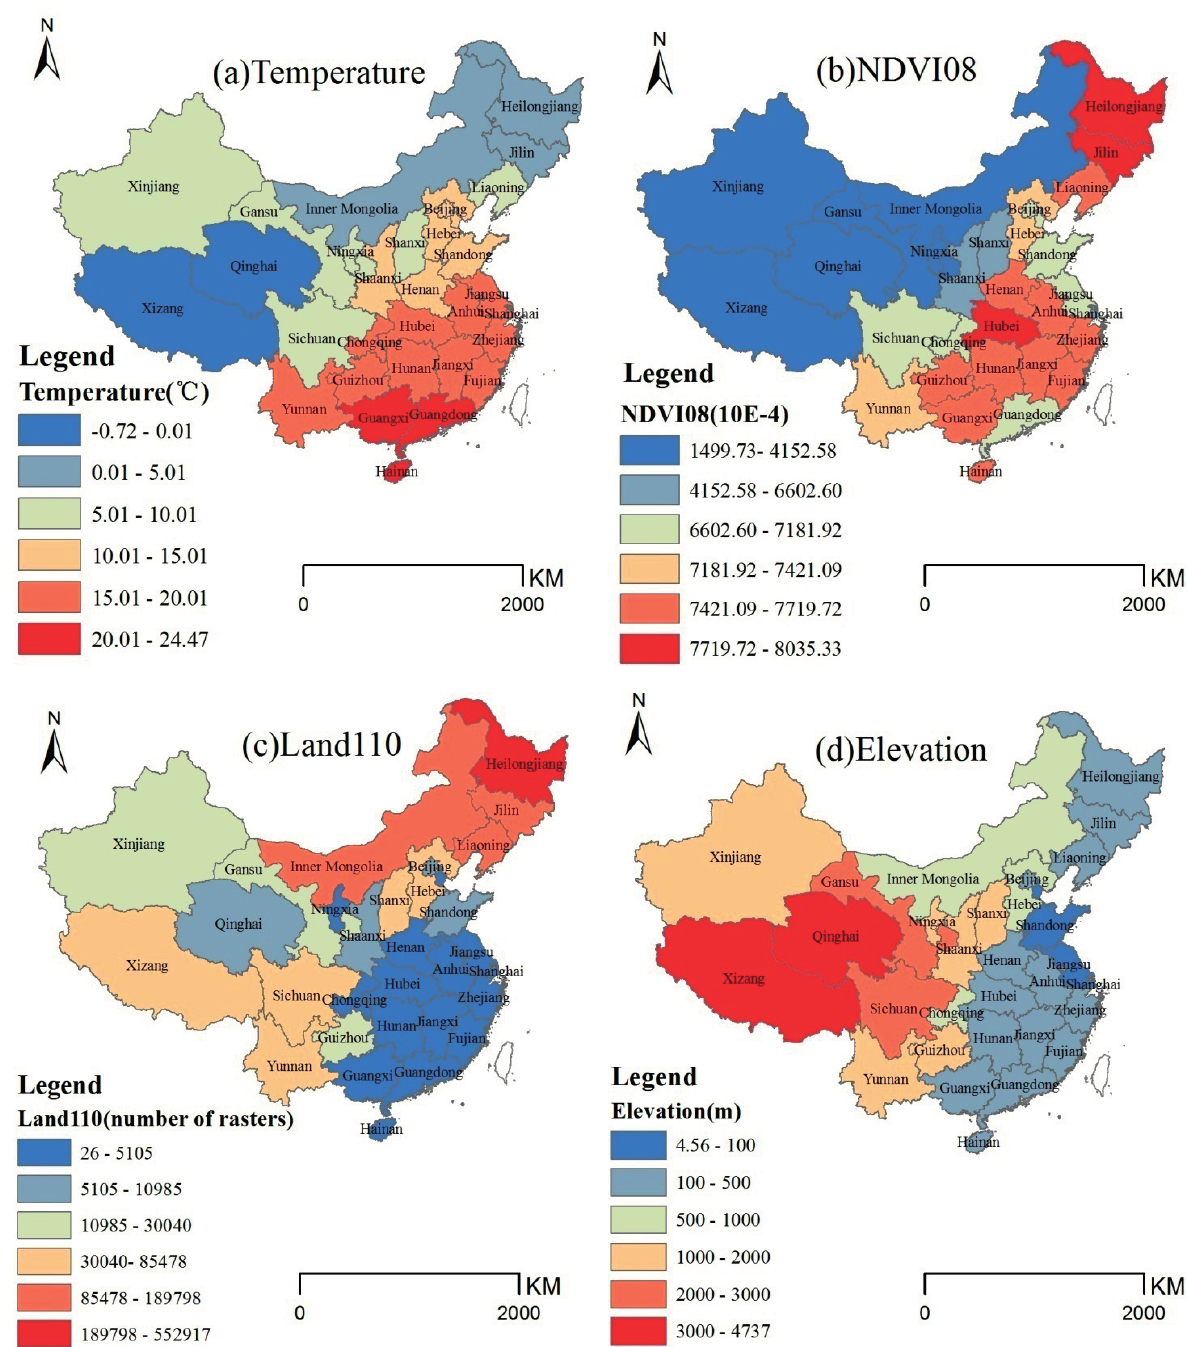
Figure 5. Independent factor distribution,